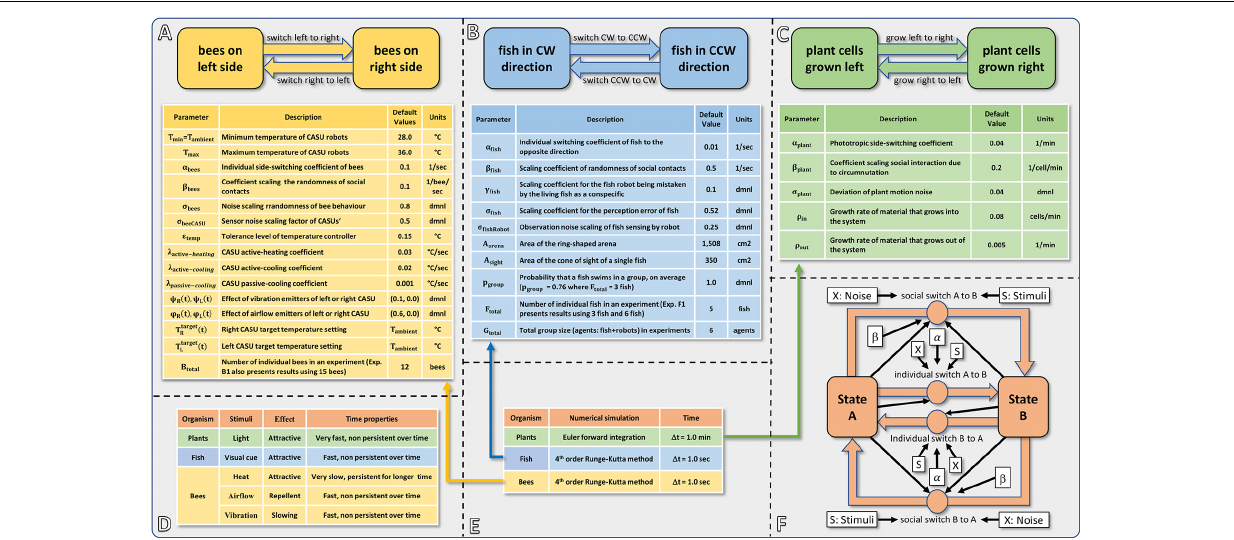
FIGURE 2 | Summarising fact sheet of our models of bees, fish, plants and robots. (A) Basic structure and model parameters of the bee and robot model. (B) Basic structure and model parameters of the fish and robot model. (C) Basic structure and model parameters of the plant and robot model. (D) Overview of the modelled stimuli, the timing scale (how fast can they be emitted, how fast can they be removed from the system, and how persistent do they stay in the environment?) and the reaction they trigger. (E) Overview of the used numerical solver method, time step size, and used dimensions of time. (F) Commonalities of the models: overview showing the basic concept of all three modelling approaches with a social component and an individual component, indicating which parameters and variables affect which of these